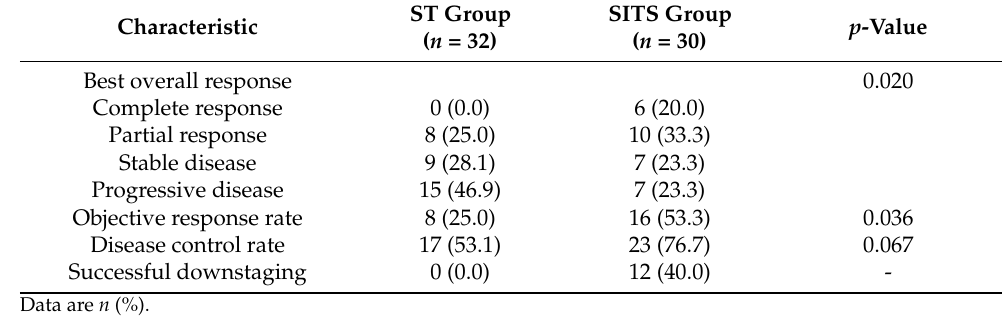
Table 2. Therapeutic efficacy.